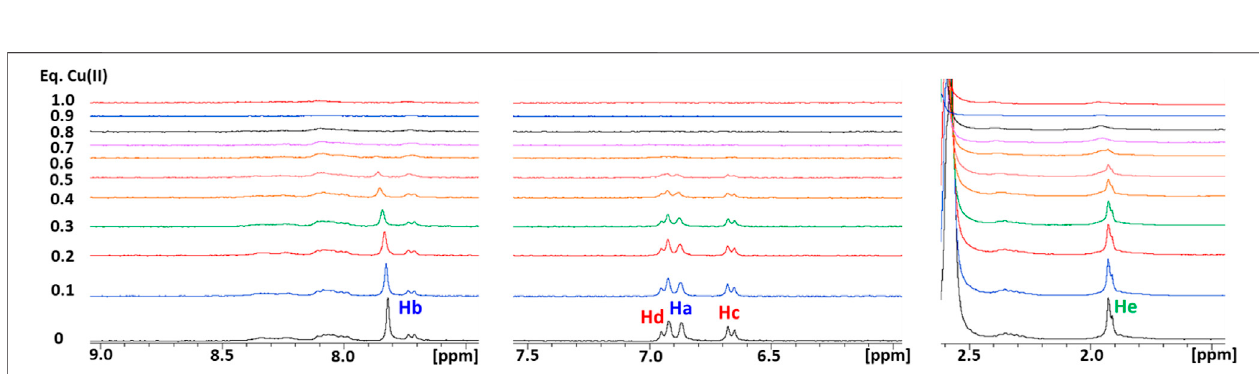
Frontiers in Molecular Biosciences |